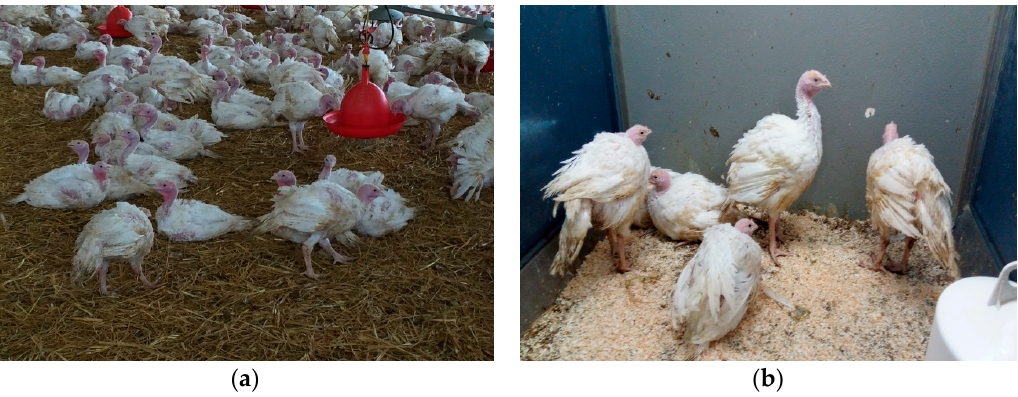
Figure 1. ( a ) Turkeys on a commercial farm with ruffled feathers, an inability to stand, abnormal gait. ( b ) Turkeys in the diagnostic trial were drowsy and moved uncoordinatedly when agitated, with a droopy head, ruffled feathers, undeveloped feather tail.